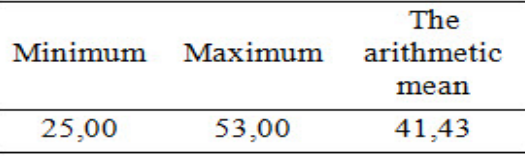
Table 4. Structure of the sample in rela